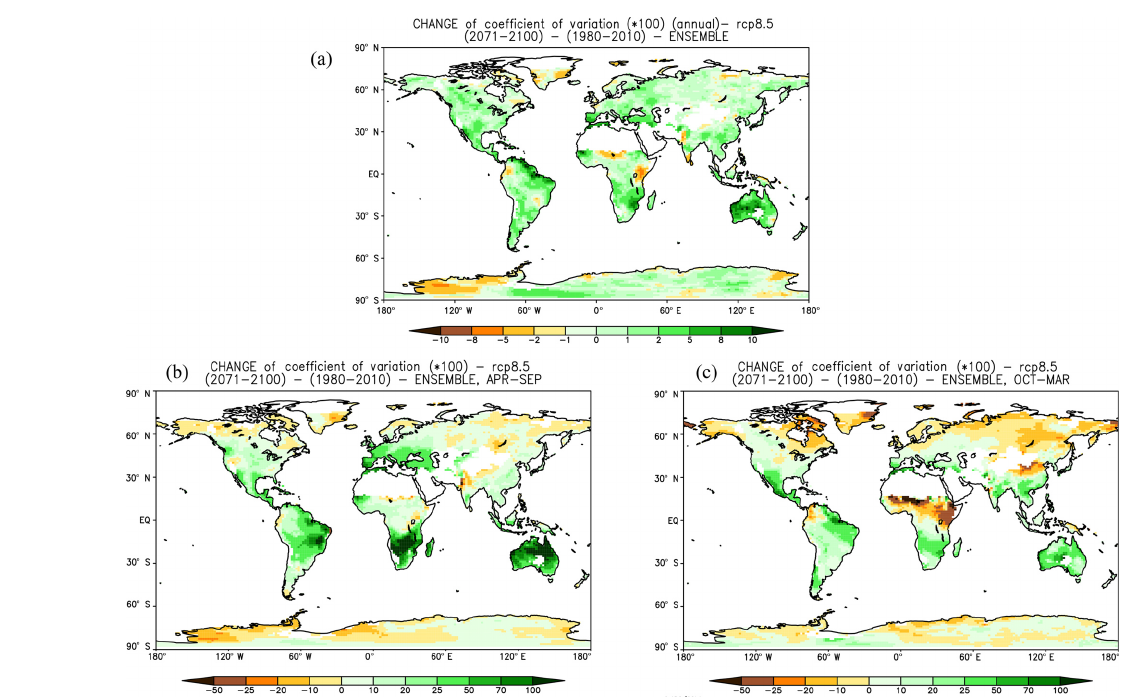
Figure 9. Change in precipitation interannual coefficient of variation (2071–2100 vs. 1981–2010) for (a) mean annual precipitation, (b) April–September precipitation and (c) October–March